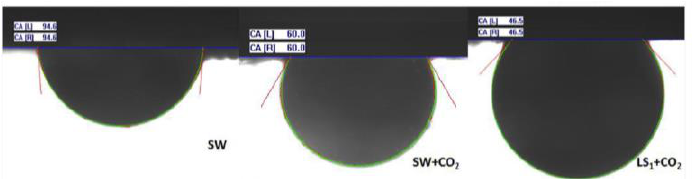
Figure 8. Contact angle between sandstone and oil-droplet at conditions A, B, and C [9]. Table 7. Measurement condition A, B and C [9].